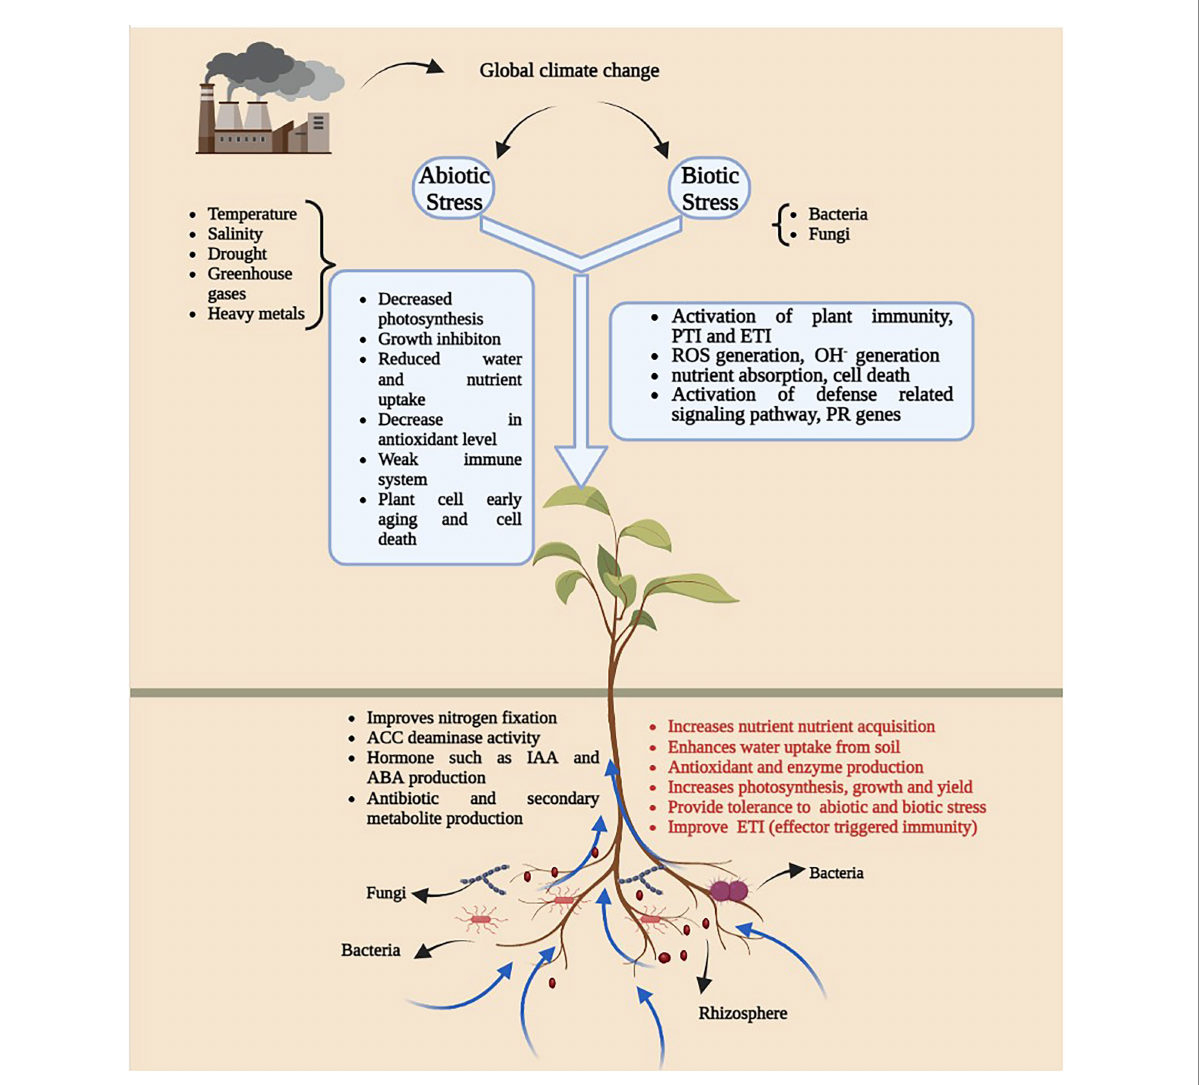
FIGURE 1 An overview of diagram illustrating the impact of global climatic change on plant-microbe interaction. Generation of abiotic and biotic stress as a result of climate change leads to several growth and development issues (White square box) in plants and microbes. Presence of plant growth promoting microbes in soil have positive impact on plant